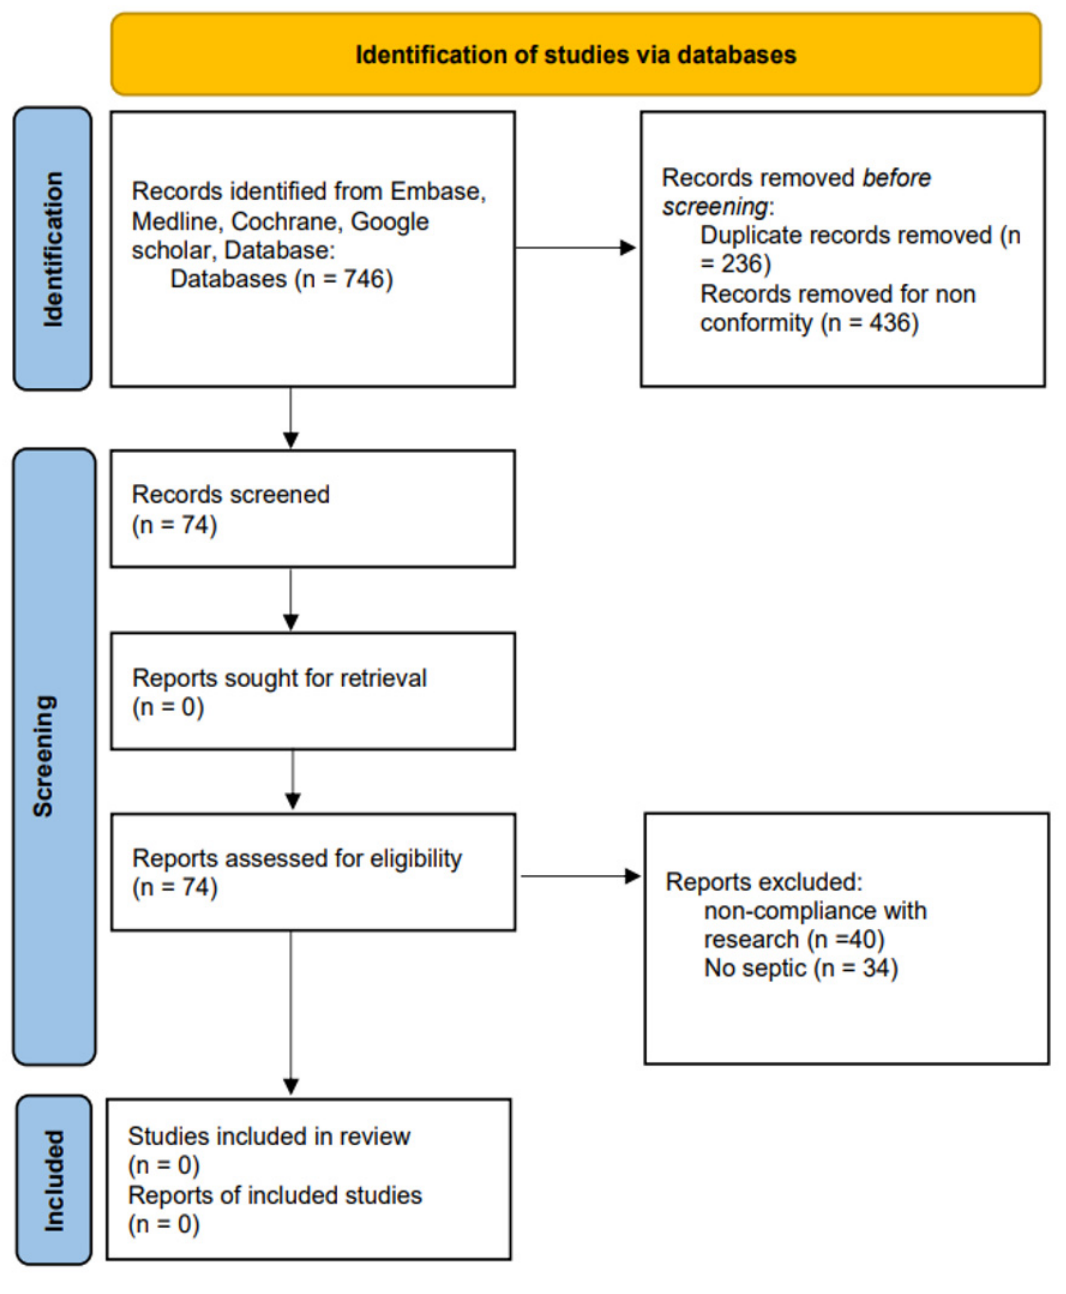
Figure 1. Flow chart of the screening process.